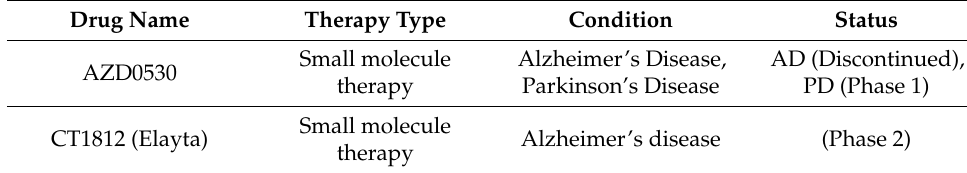
Table 5. Synaptic therapeutics of